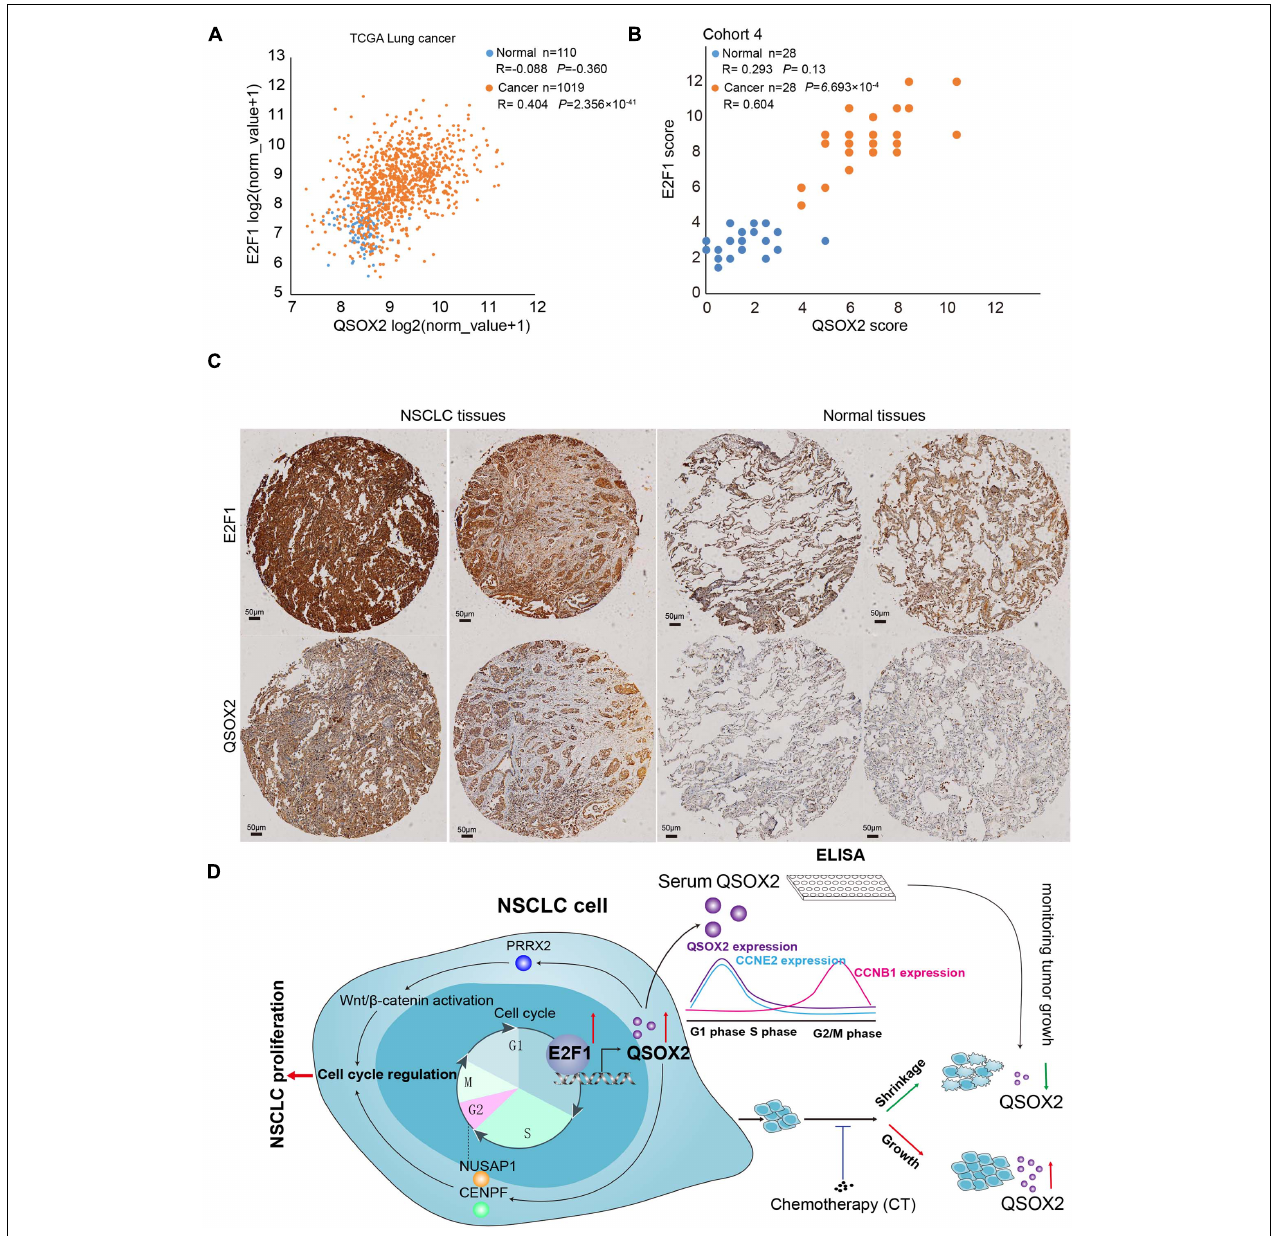
FIGURE 6 | Quiescin sulfhydryl oxidase 2 ( QSOX2 ) expression is positively correlated with E2F1 expression in NSCLC tissue. (A) Scatter plot for analyzing the correlation between E2F1 expression and QSOX2 expression in NSCLC (orange dot) and non-tumor (blue dot) tissue samples from a TCGA dataset. (B) Scatter plot for analyzing the correlation between E2F1 expression and QSOX2 expression in NSCLC (orange dot) and non-tumor (blue dot) tissue samples from the 28 NSCLC patients (data from TMA cohort 4). (C) IHC detection of QSOX2 and E2F1 expression in representative NSCLC samples and Normal tissues. (D) A schematic model showing our findings in this